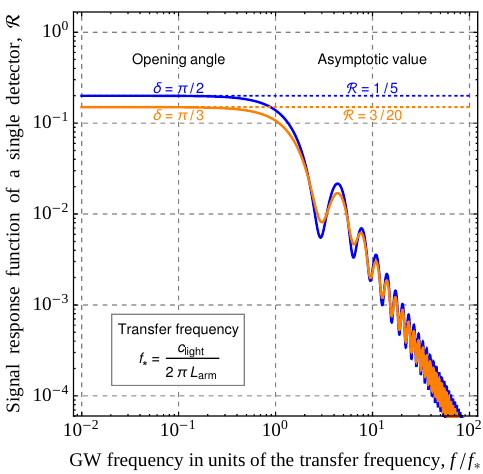
Figure 10 . Signal response function for an equal-arm Michelson